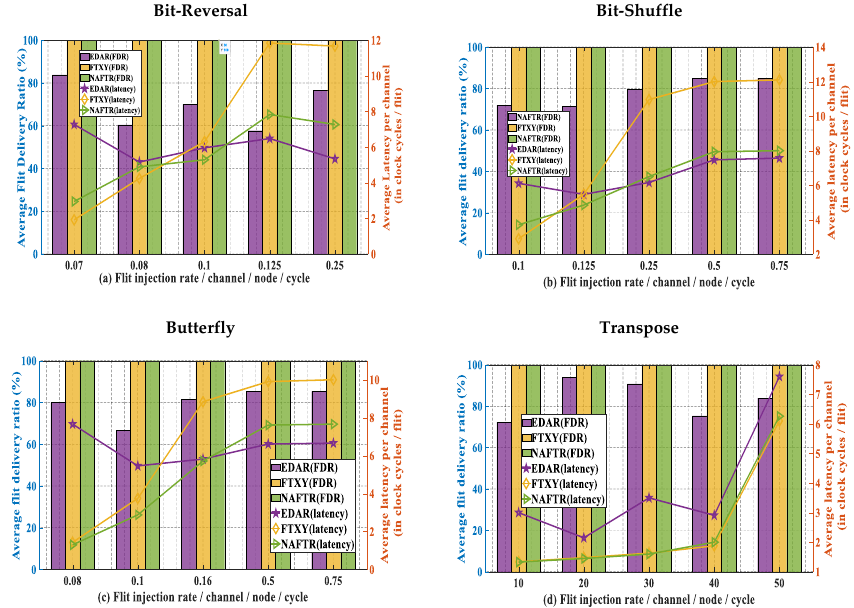
Figure 7. Average latency vs. average flit delivery ratio comparison under synthetic traffic patterns at different pack injection rates in a fault-free scenario.